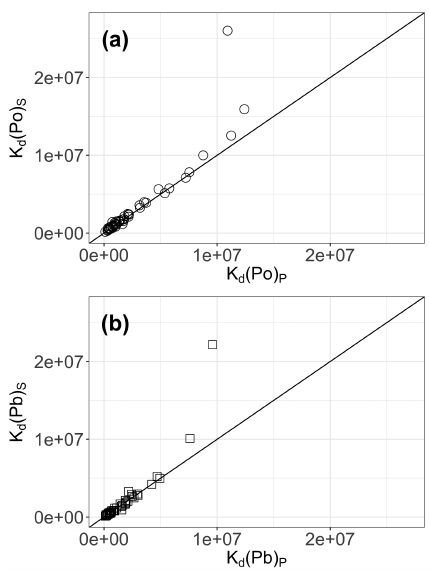
Figure 10. Comparison of the partitioning coefficient ( K d , Lkg − 1 ) between the dissolved and small particulate phases ( K d (Po) s , K d (Pb) s ) vs. between the dissolved and total particulate phases ( K d (Po) p , K d (Pb) p ) for (a) 210 Po and (b) 210 Pb. The 1:1 line is indicated as the solid line in each